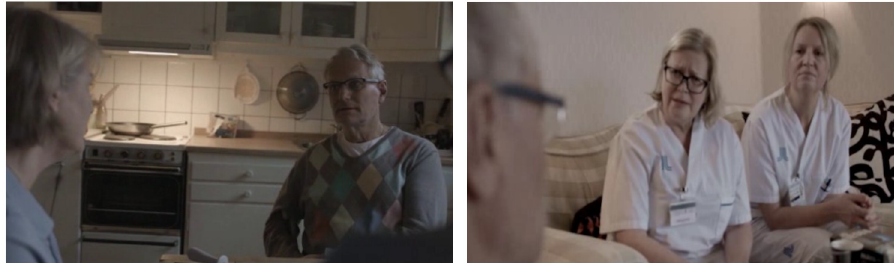
Fig 2. Screenshots from the video clips showing home visits by three different health professions—An occupational therapist on the left and a family physician and district nurse on the right.